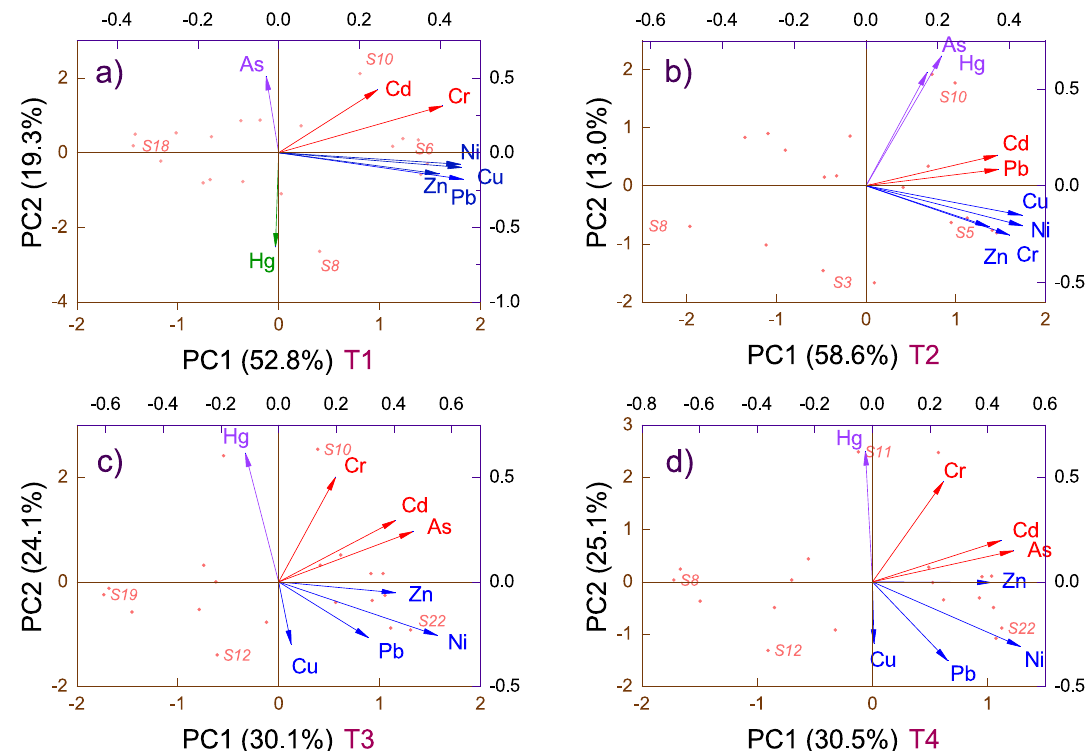
Figure 2. PCA of heavy metals in Olt River middle and lower riches measured during four periods of 2018 [ a — March (T1); b —May (T2); c —June (T3); d —October